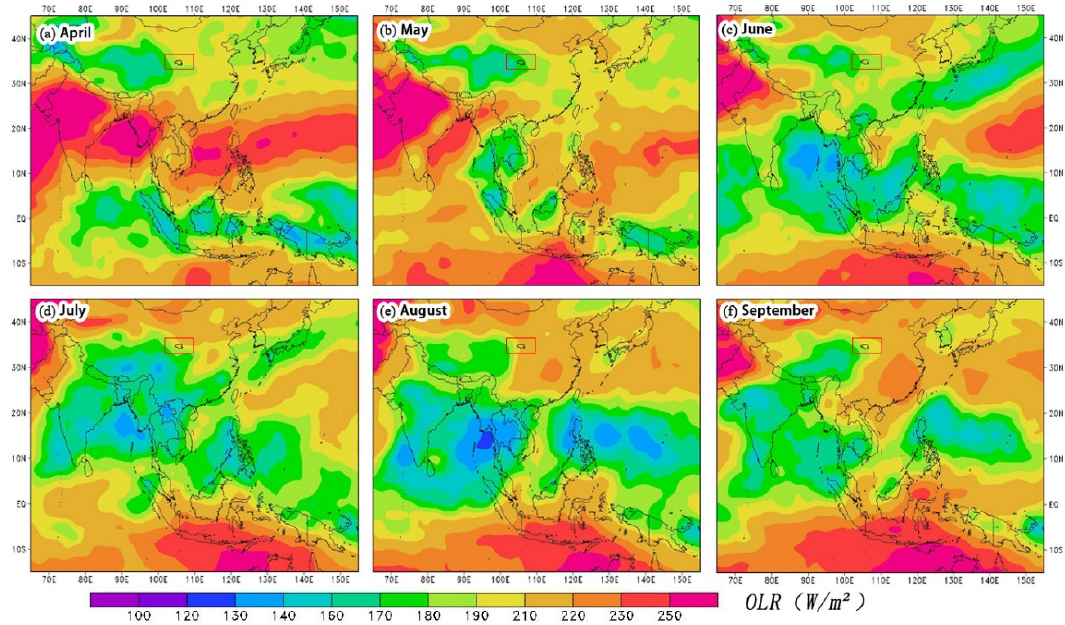
Figure 5. The distribution of OLR in ( a ) April, ( b ) May, ( c ) June, ( d ) July, ( e ) August and ( f ) September 2019. The red rectangle shows the Zone 1 region discussed in the text.